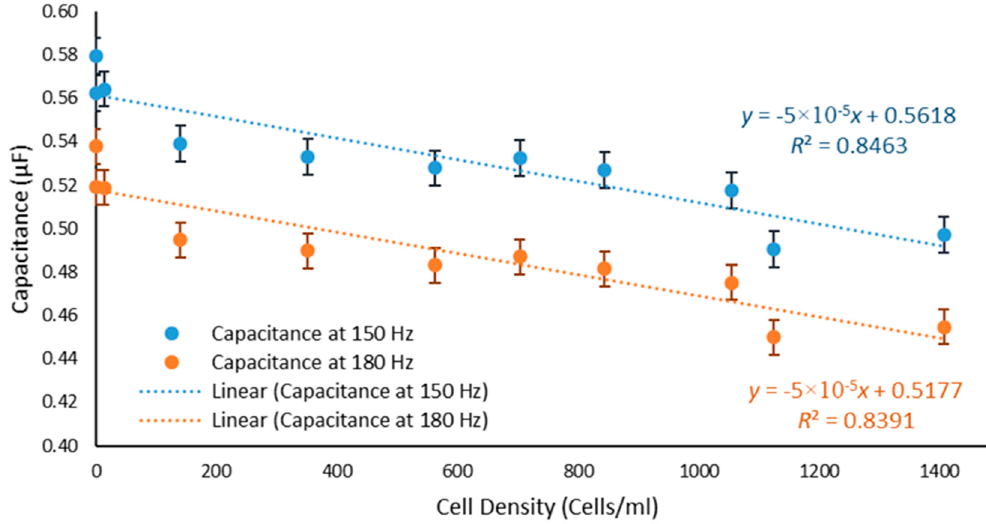
Figure 4. Dependence of capacitance on cell density.